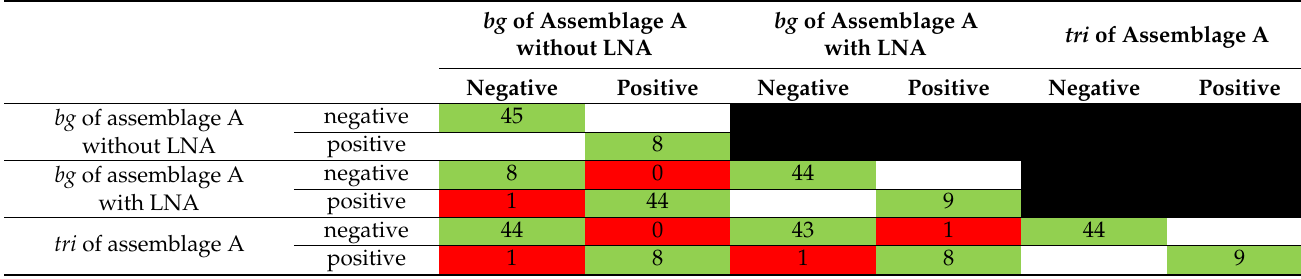
Table A5. Cross-table detailing mismatches between the real-time differentiation PCR assays targeting the G. duodenalis assemblage A. Green = matching results. Red = mismatching results. Black = not filled in to avoid repetition.